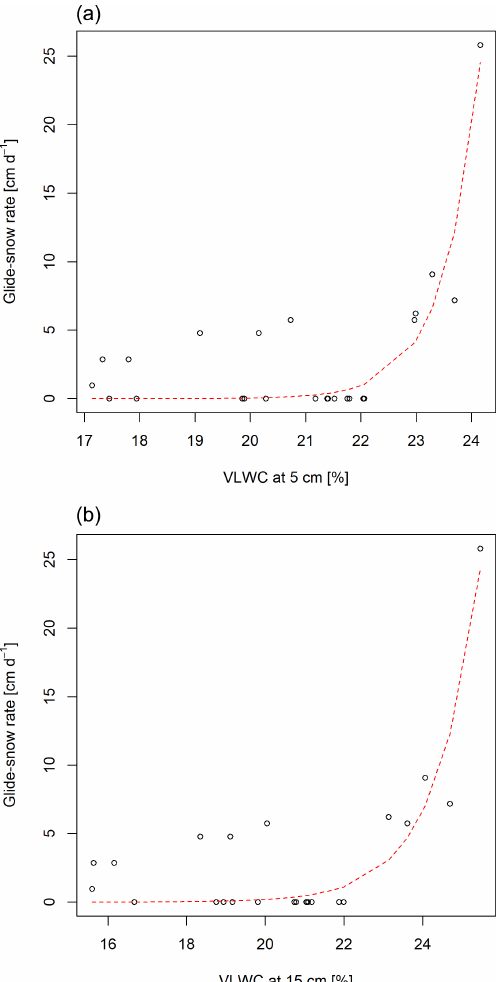
Figure 9. Fitting model between daily glide-snow rates for S1 and volumetric liquid water content (VLWC) measured in Pista Nera at 5cm (a) and 15cm (b) soil depths during the warm events of the 2014